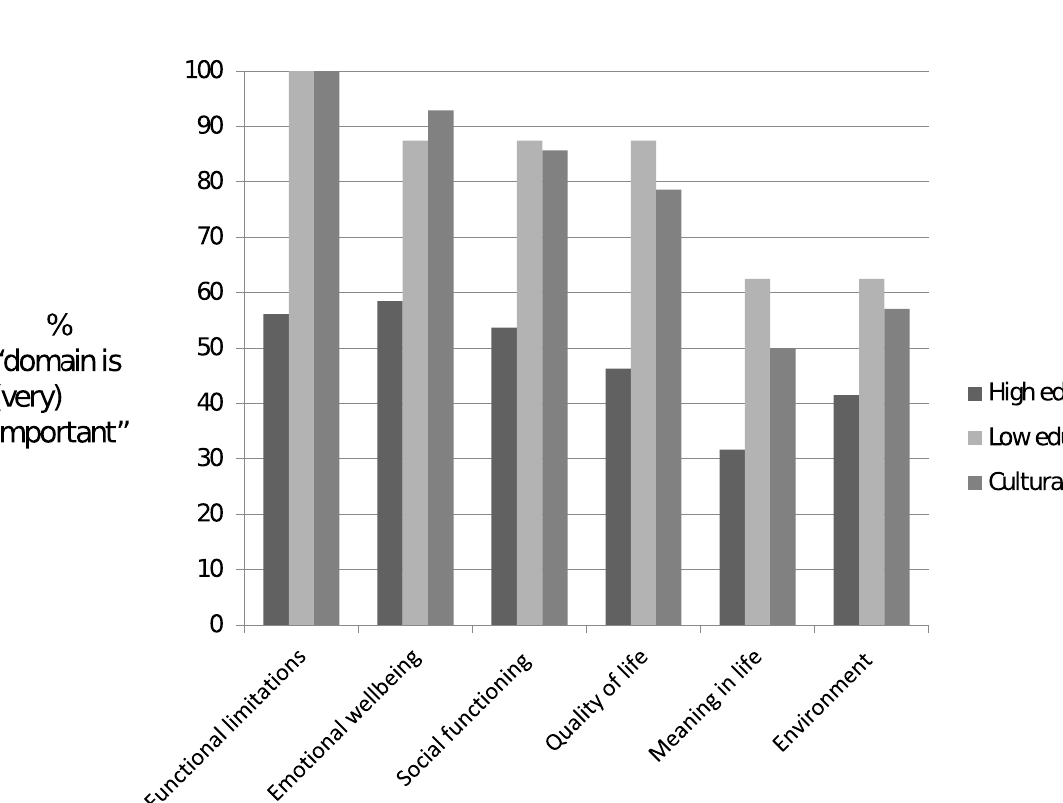
Fig 4. Overview of the assessments of the health domains by subgroups of participants. Frequency distribution (%) of the importance of discussing each domain with healthcare professionals. The light gray row represents the highly educated participants, the middle gray row represents the participants with a low level of education and the dark gray row represents participants from culturally diverse